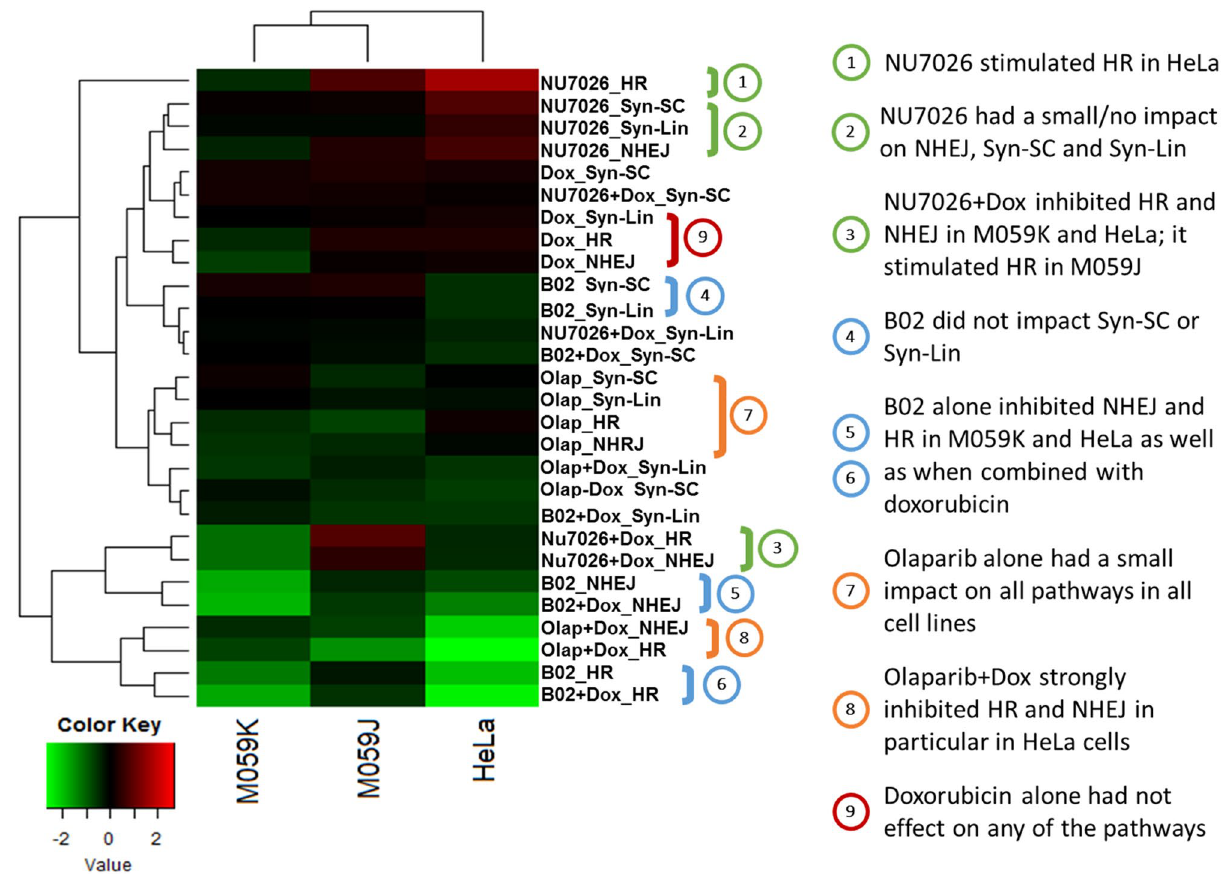
Figure 5. Unsupervised hierarchical clustering with Euclidean dissimilarity of DSB repair responses across treatments in three cell lines. Heatmap based on the log2 ratios of the fluorescence intensity between treated and non-treated samples (log2(T/NT)). Positive values are shaded in red and indicate a stimulation of repair activities compared to control cells, whereas negative values, colored in green, indicate an inhibition. Values around zero (in black) indicate no significant effect of the treatment. Green brackets highlight results after NU7026 exposure (groups 1, 2 and 3); blue brackets highlight results following B02 exposure (groups 4, 5, 6); orange brackets highlight results following olaparib exposure (groups 7 and 8); red bracket highlights results following doxorubicin exposure (group 9). HR strand invasion, NHEJ end-joining, Syn-SC DNA synthesis on SC-plasmid, Syn-Lin DNA synthesis on Lin-plasmid, Dox doxorubicin, Olap